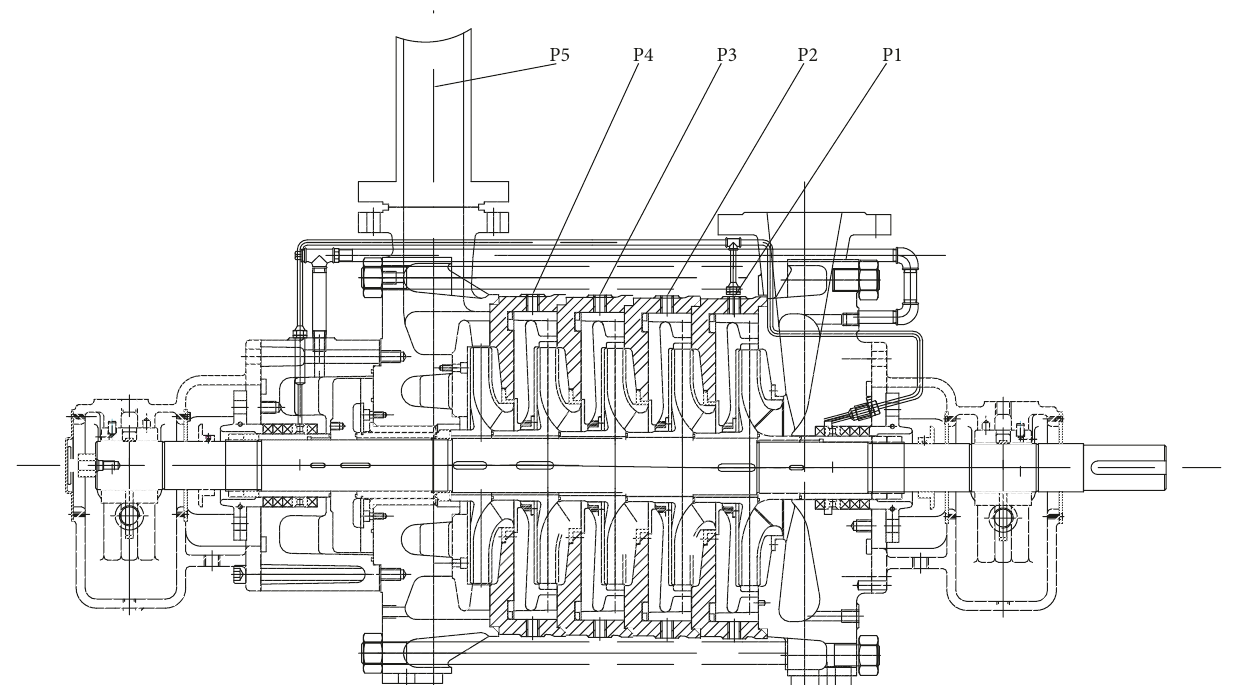
Figure 3: Location of the pressure fluctuation monitoring points.